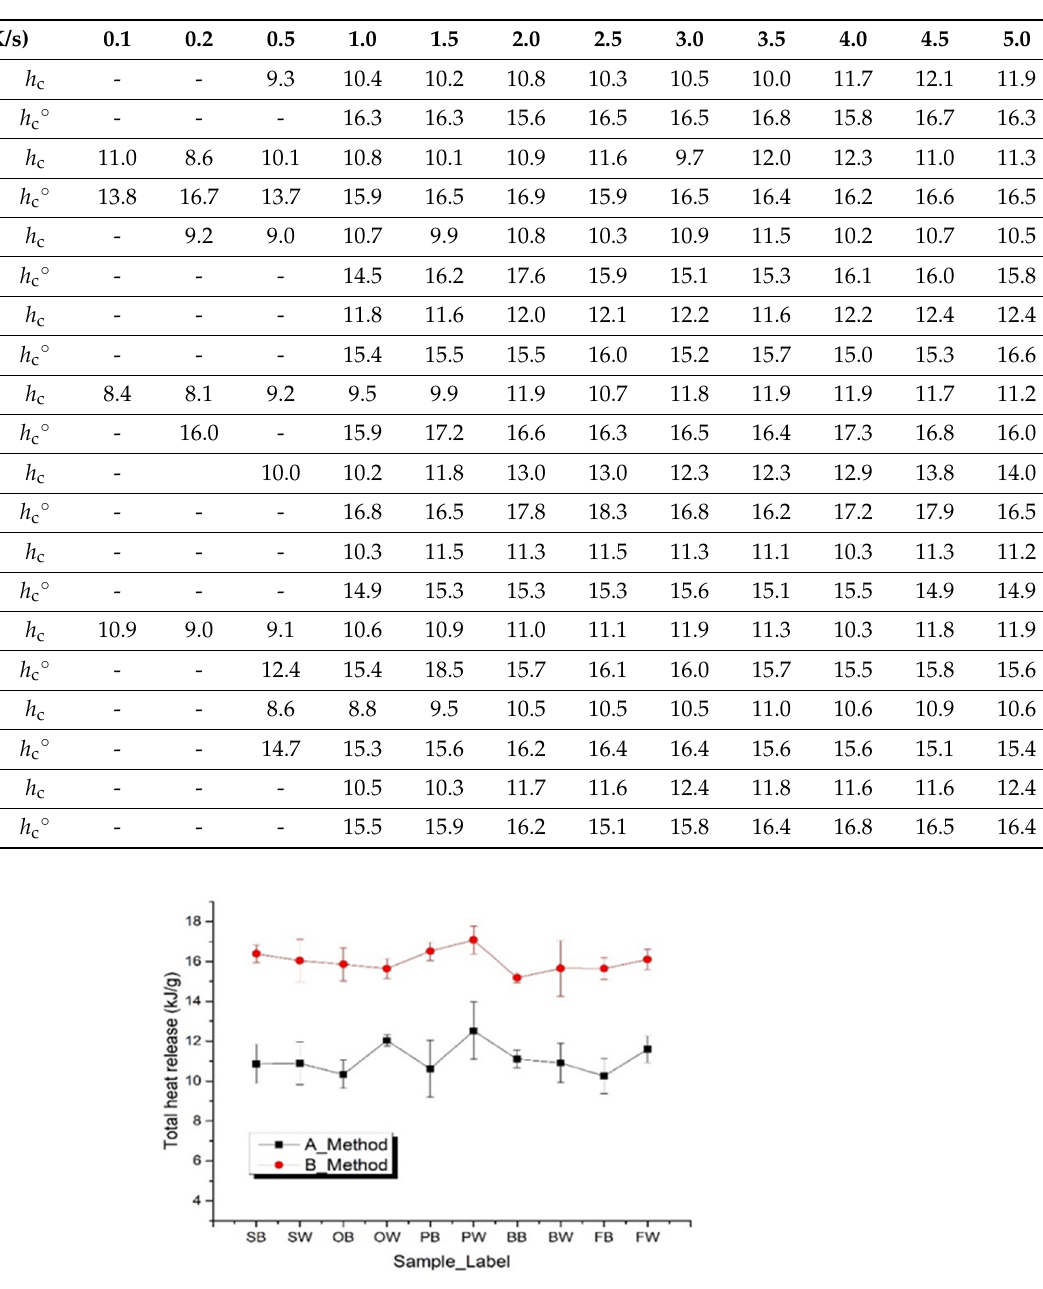
Figure 6. Total heat release of all thirteen samples with comparison of Methods A and B.